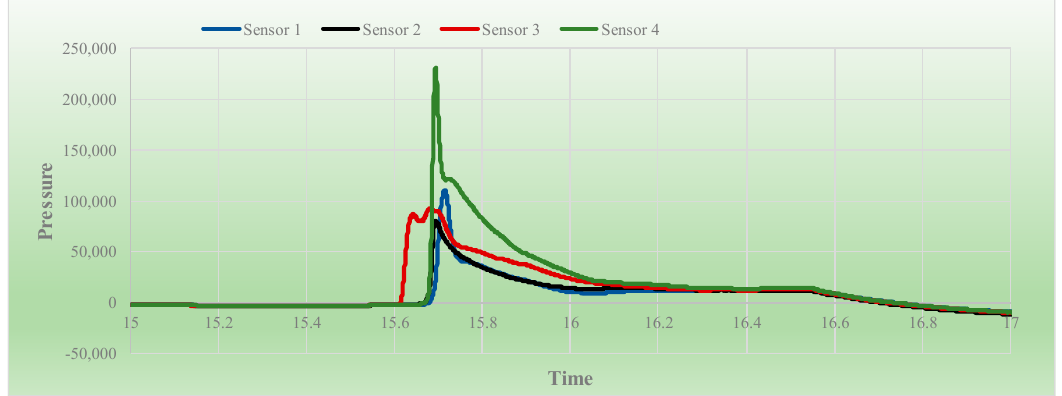
Figure 20. Comparison of pressure time-histories for sensors 1 to 4 of the actual-size tank with 14 m of water.